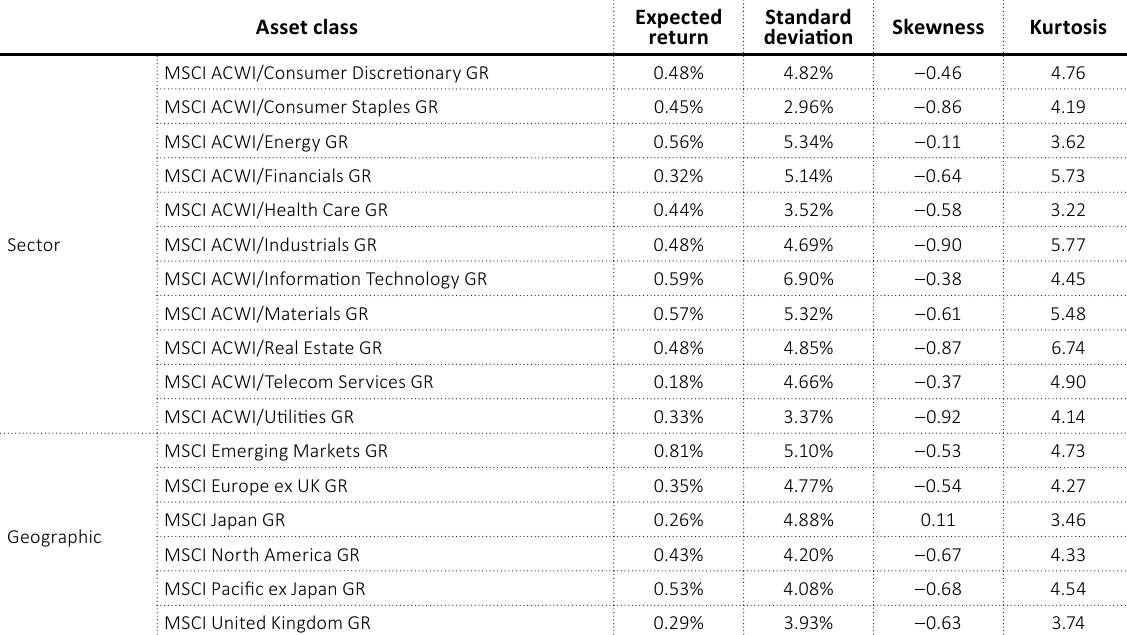
Table 2. Descriptive statistics of the benchmarks’ excess returns Asset class